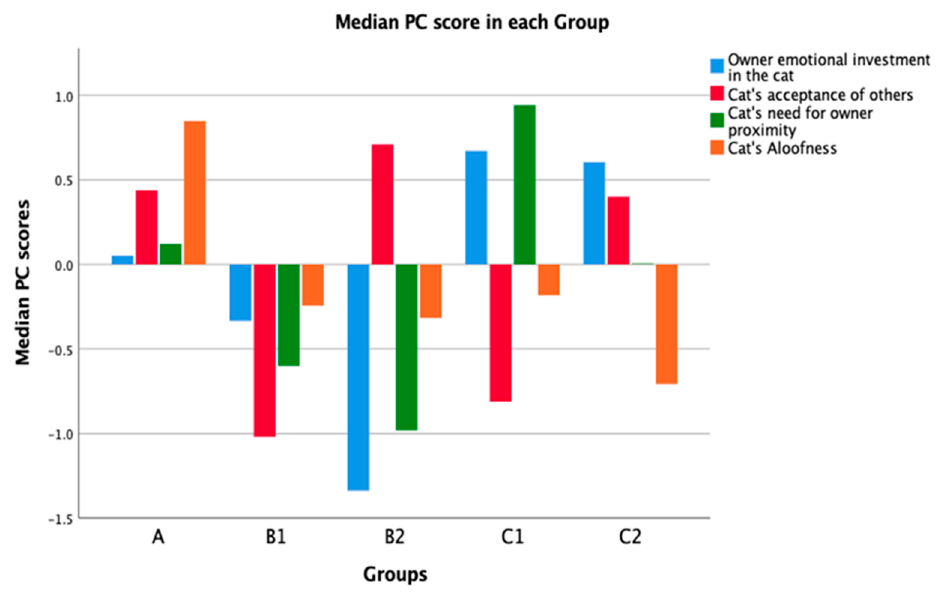
Figure 2. Bar chart representing the median PC scores in groups A, B1, B2, C1 and C2. “Owner’s emotional investment in the cat” varied between groups (X 2 : 1011.240, p < 0.001). Post hoc tests showed that, with the exception of groups C1 and C2 ( p = 0.91), all There were four reliable items that did not load on any PC. Their scores were signif- icantly different between groups A, B1, B2, C1 and C2.